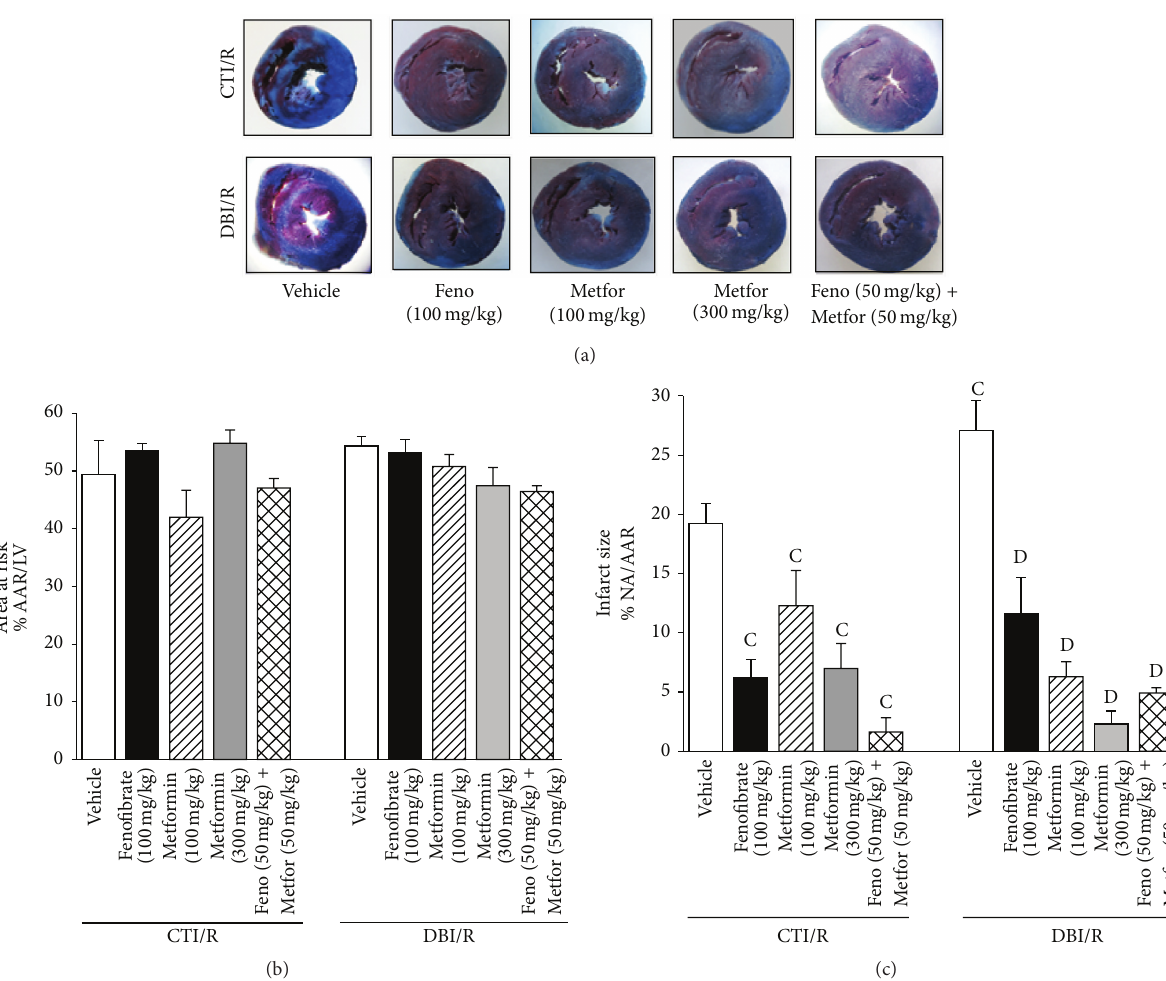
Figure 4: Subchronic treatment with fenofibrate (F), metformin (M), and their combination reduced infarct size in control-ischemia/reper- fusion (CTI/R) and diabetic-ischemia/reperfusion (DBI/R) conditions. (a) Representative photographs of Evans blue/triphenyltetrazolium chloride dyed heart slices from CTI/R and DBI/R rats, the blue area represents the area with viable tissue, the red area is the area at risk (AAR), and the white regions are the necrotic areas (NA). (b) Area at risk and (c) infarct size of the different groups, expressed as a percentage of AAR in the left ventricle and percentage of NA in the AAR, respectively. C 𝑃 < 0.05 versus CTI/R-Vehicle and D 𝑃 < 0.05 versus DBI/R-Vehicle two-way ANOVA followed by Duncan’s post hoc test. Data are presented as means ± SEM of 4–6 animals per